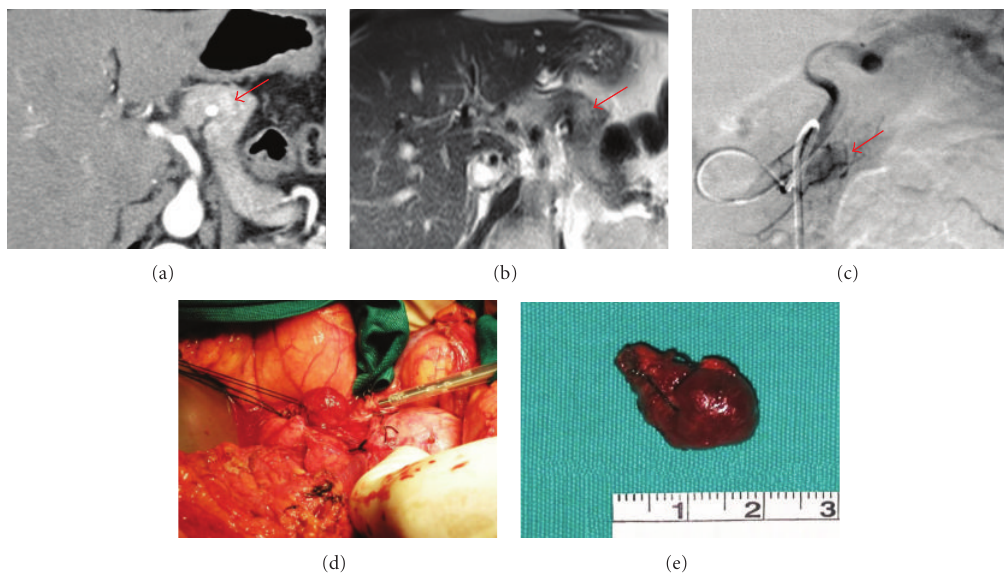
Figure 1: Imaging studies and intraoperative appearance. (a) A contrast-enhanced computed tomography slice of the upper abdomen, showing a mildly hyperintense nodule, about 1cm in diameter, located between the body and the tail of the pancreas (red arrow). (b) A gadolinium-enhanced magnetic resonance slice of the upper abdomen, showing a mildly hyperintense nodule, about 1cm in diameter between the body and the tail of the pancreas (red arrow), in the same location as identified by CT. (c) A digital subtraction angiography with the catheter positioned in the proximal splenic artery, showing nodular vascularization from the arteria pancreatica magna (red arrow). (d) Isolation and enucleation of the adenoma using the CUGA Excel system. (e) Macroscopic appearance of the adenoma soon after resection (scale bar in cm).